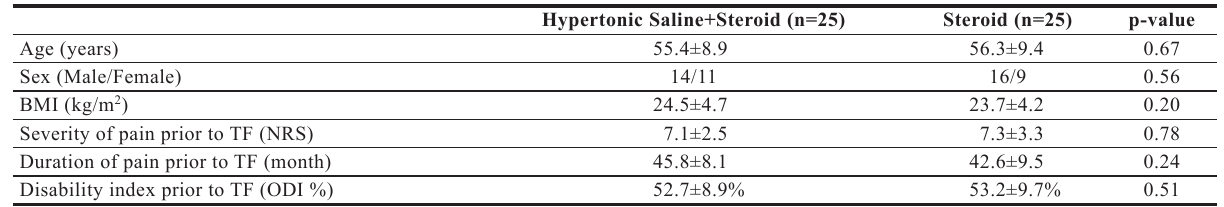
Table 1. Demographic characteristics of